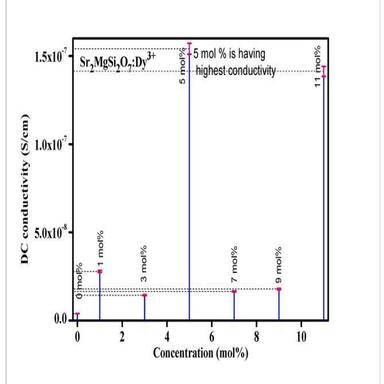
DC conductivity versus concentration for Sr2MgSi2O7:Dy3þ NPs.